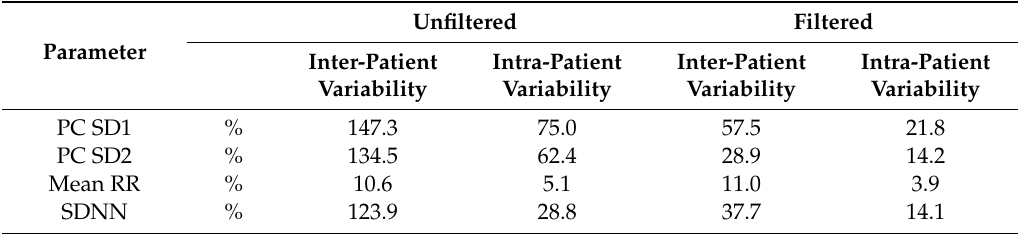
Table 3. Inter- and intra-patient variability for Poincar é SD1 (PC SD1) and SD2 (PC SD2), as well as overnight mean RR-interval (mean RR) and total overnight RR-interval variability (SDNN) based on the data acquired in the home setting. Data are presented with (filtered) and without (unfiltered) the application of the RR-interval